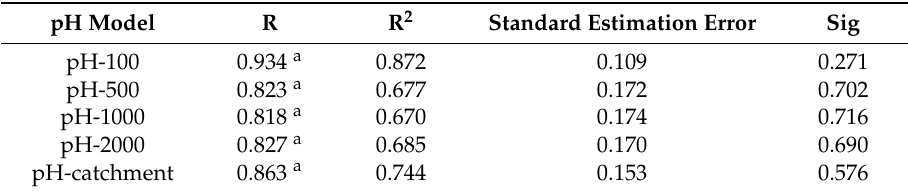
Table 5. The linear model general situation of pH.